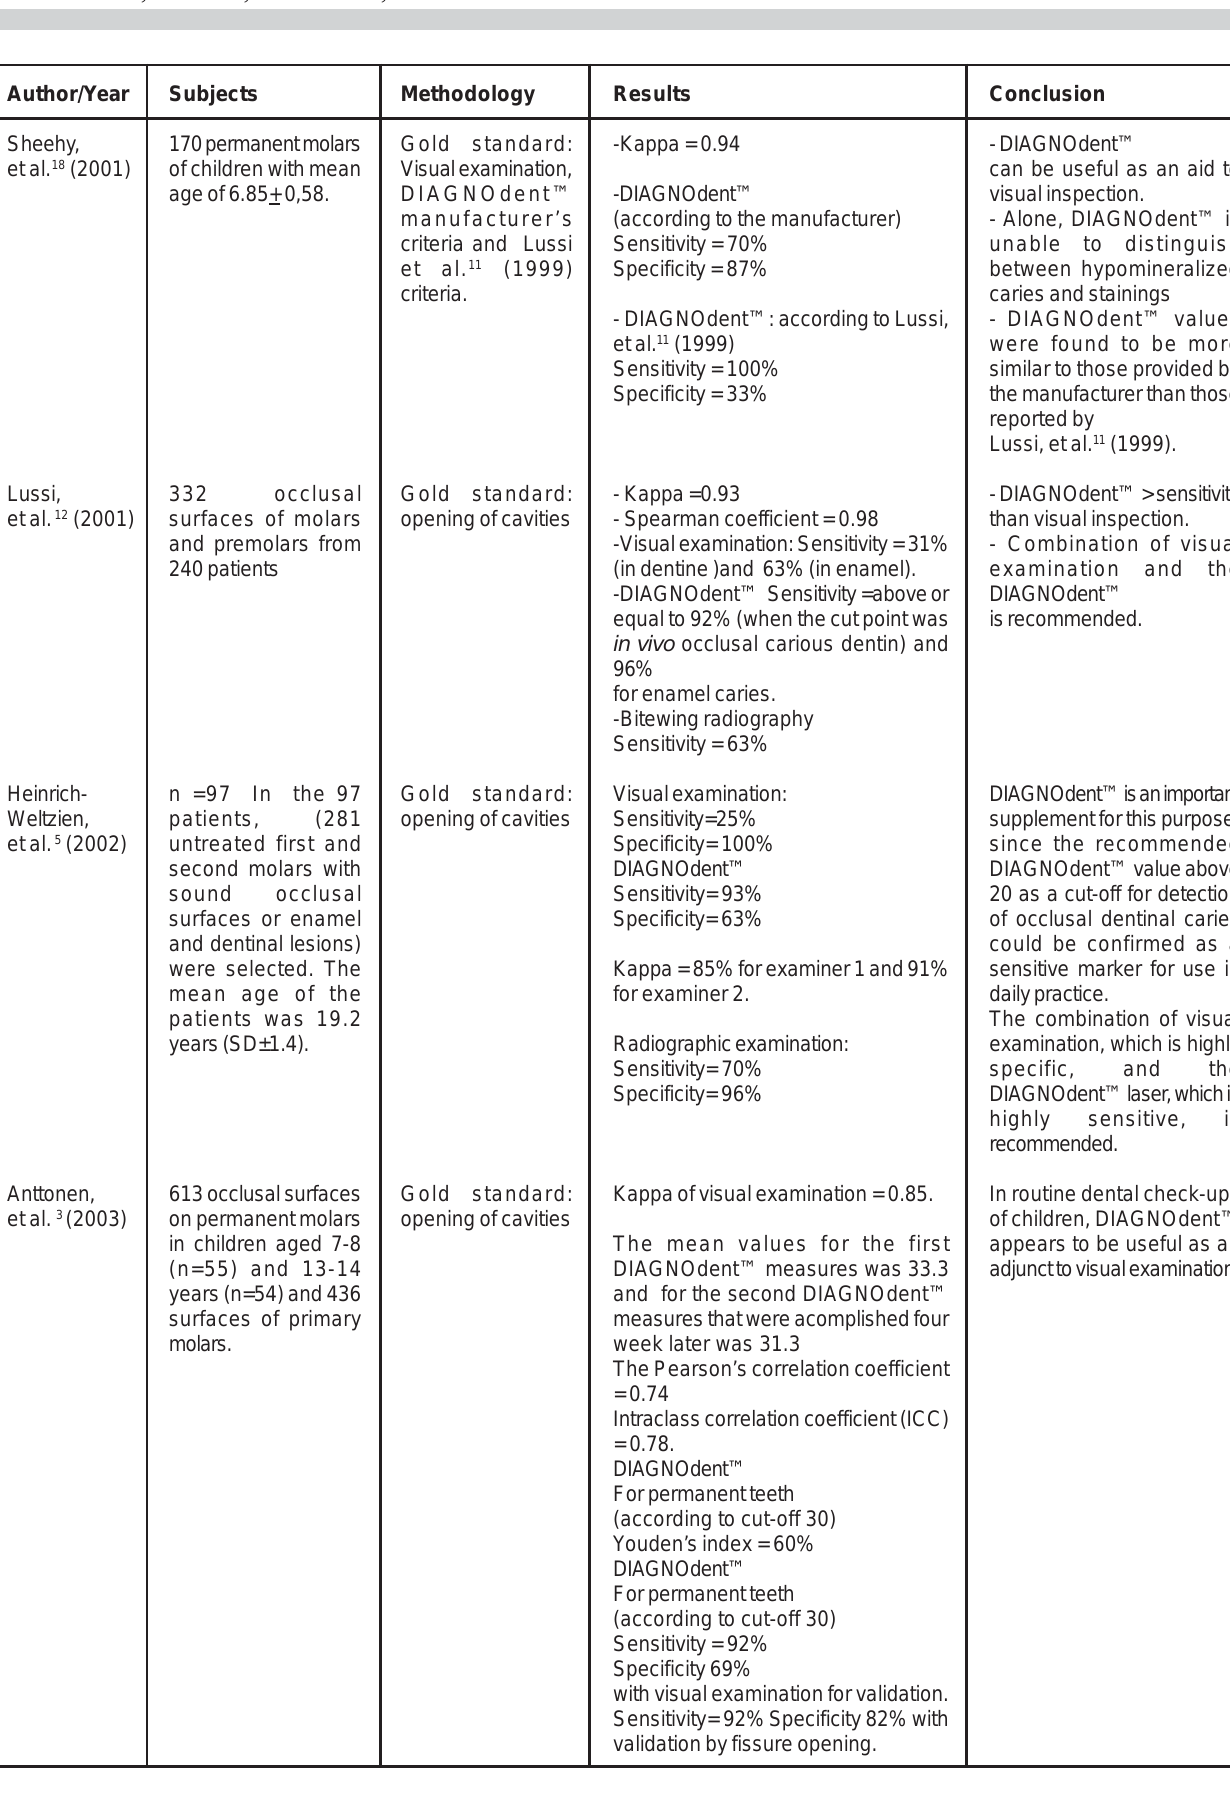
FIGURE 1- Selected studies about DIAGNOdent™ employed on in vivo occlusal surfaces of permanent